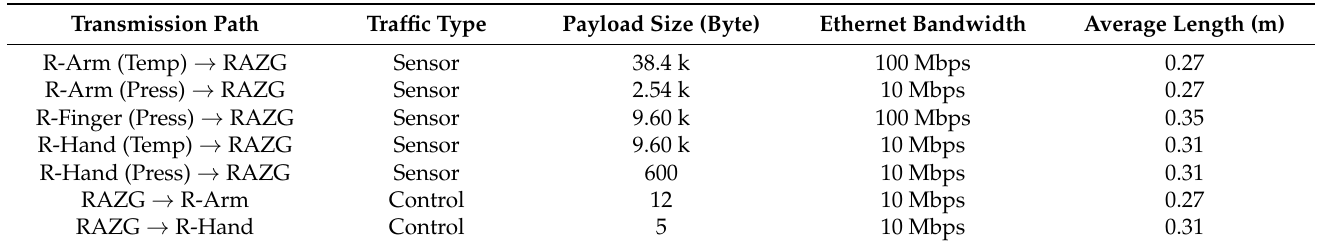
Table 7. Data transmission link parameters of the ZIRA Right Arm and Hand Zone.